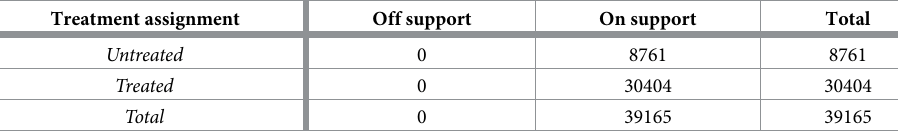
Table 4. Common support range of one-to-one nearest neighbor matching (with